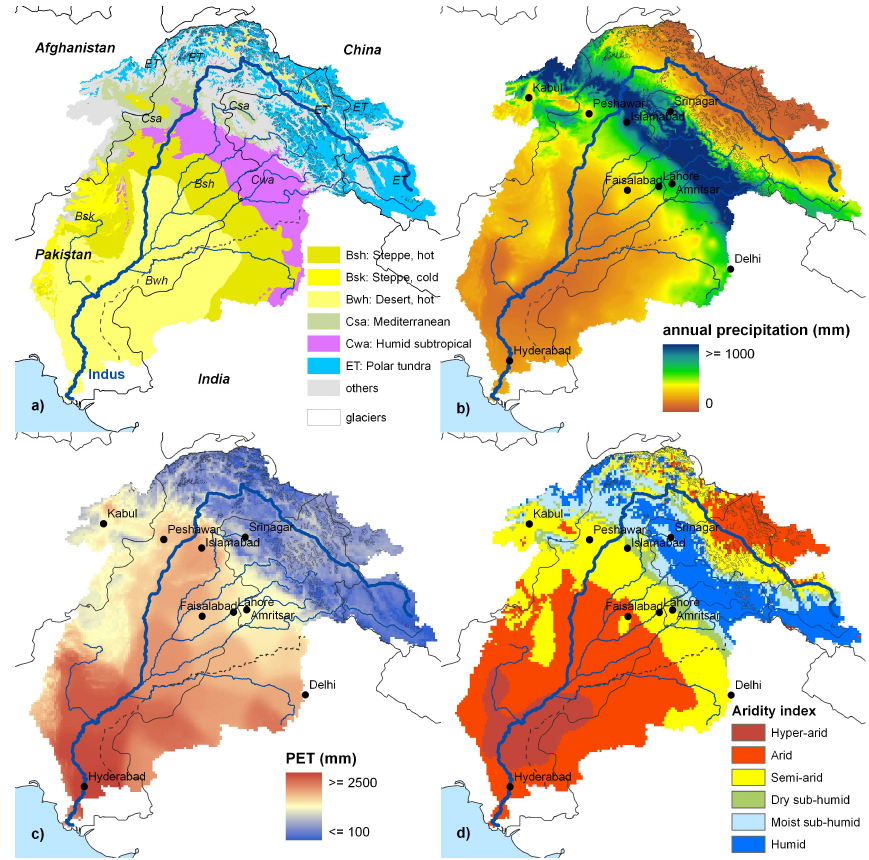
Fig. 2. Climatology within the Indus basin: (a) major climatic zones 1950–2000 – the K¨oppen-Geiger system of climate classification (K¨oppen, 1936) adapted according to Hijmans et al. (2005) by de Bie (2007); (b) average annual precipitation (mm) for the period 1950– 2000, according to Hijmans et al. (2005); (c) average annual potential evapotranspiration PET in mm (interpolated surface from FAOClim- Database) calculated as ETo after the FAO Penman-Monteith equation (Allen et al., 1998); (d) aridity index (AI=PET/ P ) as defined by UNEP